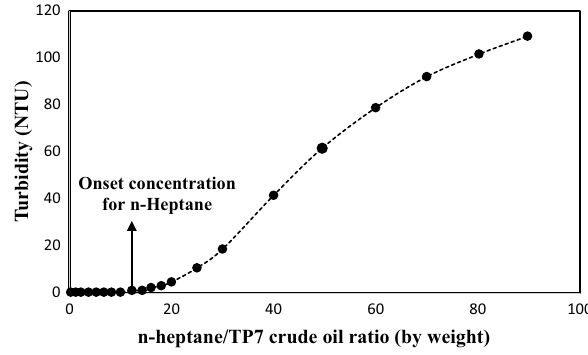
Fig. 30 Turbidity value versus added heptane for TP7 oil